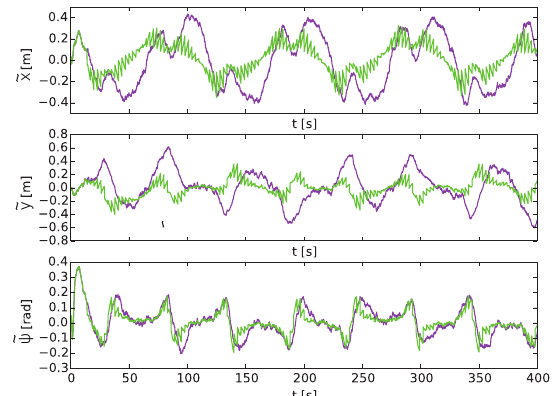
Figure 4: Simulation of the robot showing pose er- ror with respect to time. Simulated with τ C = 3 s and τ D = 2 s . Purple indicates UKF, green indicates JUKF.